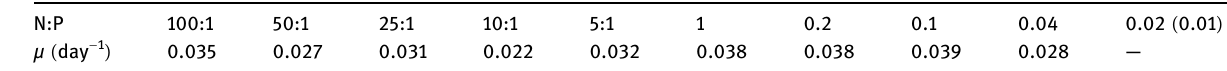
Table 1: The speci fi c growth rate of M. aeruginosa cultured under di ff erent N and P supply ratios